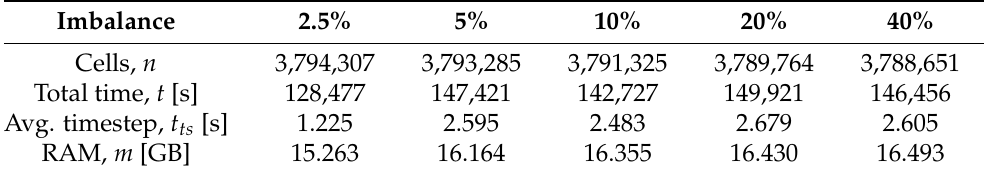
Table A13. Influence of the load balancing (imbalance adjustment) on the computational time. Setup is identical to Table A7 with refinement frequency set to 10 timesteps.